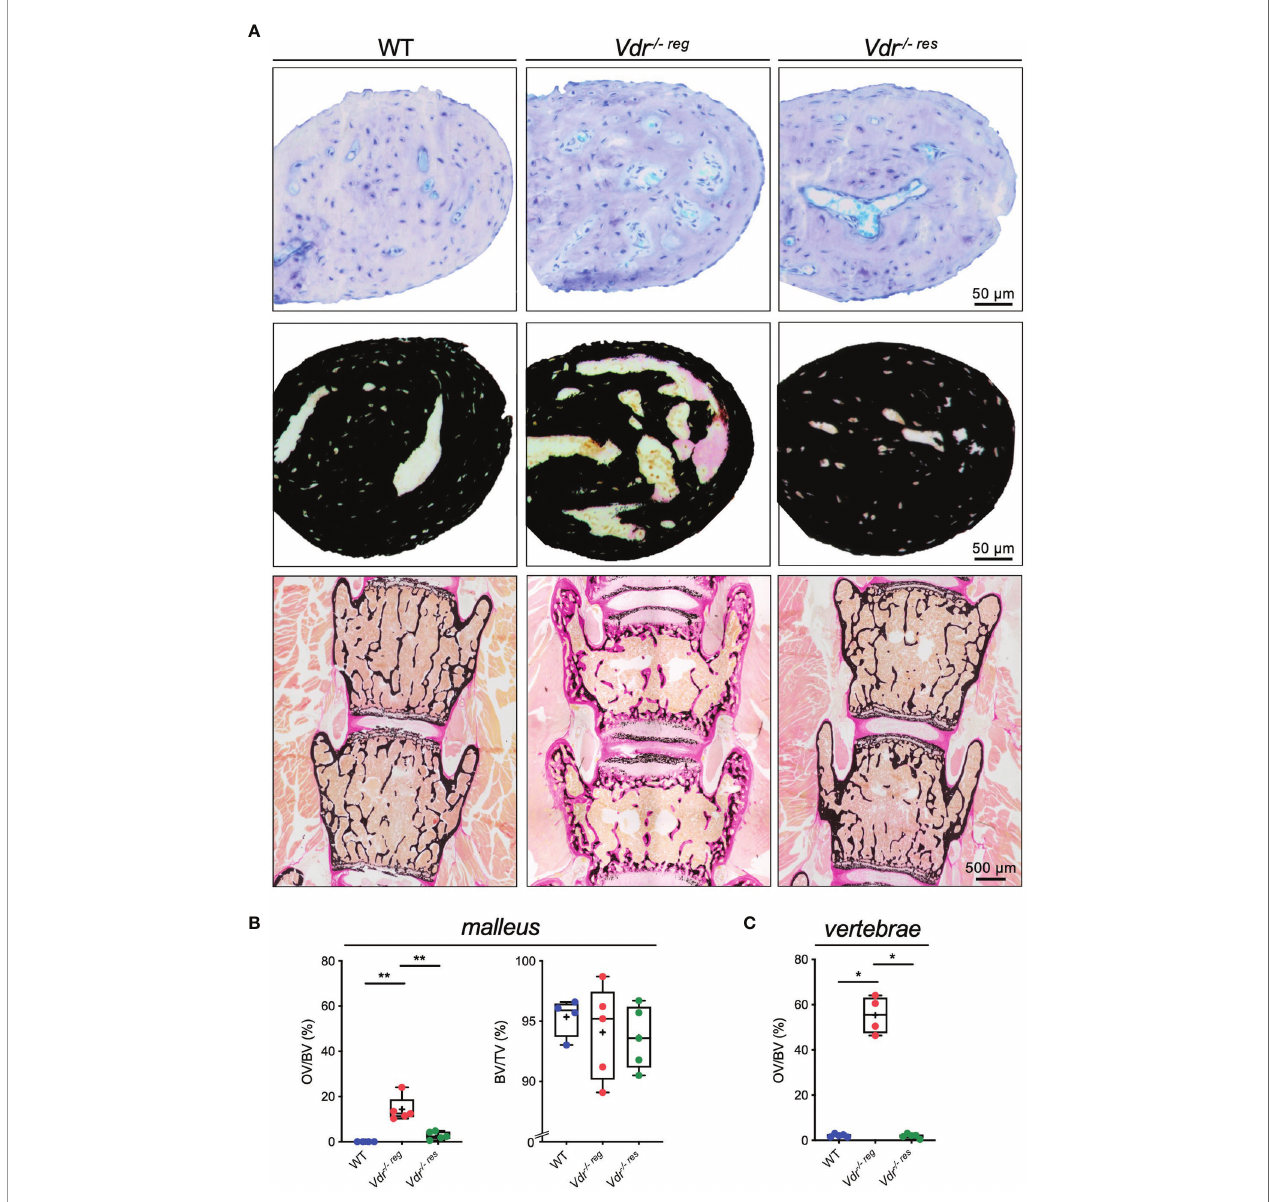
FIGURE 3 | Undecalci fi ed histology identi fi es partial reversibility of hyperosteoidosis in the malleus as opposed to the lumbar spine. (A) Representative histological images of toluidine blue (upper panel) and von Kossa-van Gieson (middle panel) stained orbicular apophysis of the malleus in 10-weeks old WT, Vdr -/- reg and Vdr -/- res mice. Histological images of the lumbar vertebral bodies in von Kossa-van Gieson staining (lower panel). (B) Histomorphometric evaluation including osteoid volume per bone volume (OV/BV) and bone volume fraction (BV/TV) in the malleus and (C) OV/BV in the vertebral body. ANOVA and repeated measures with Holm-Sidak correction was performed in panels (B – C) . *p<0.05;